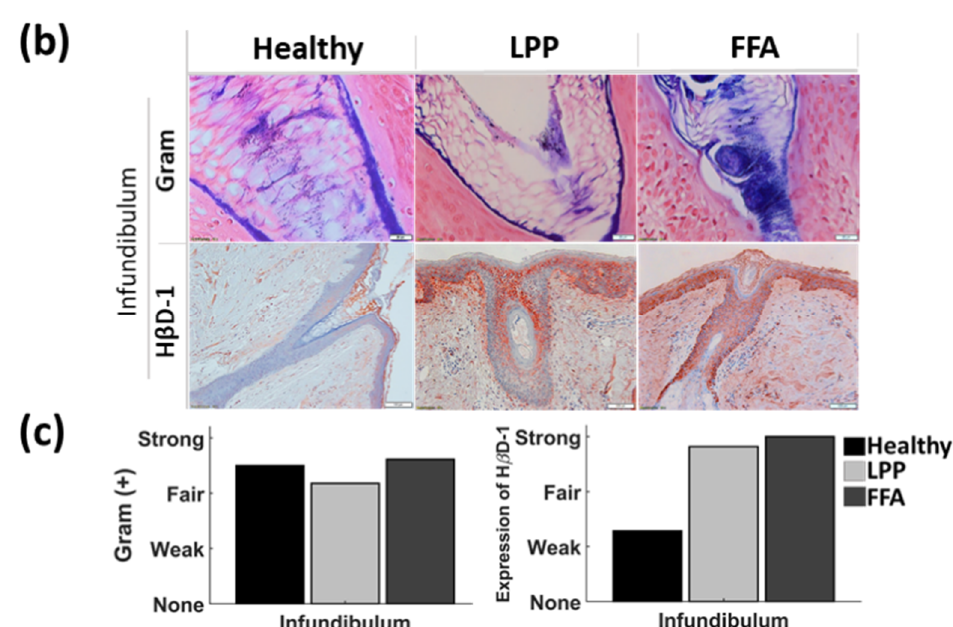
Figure 4. Bacterial profiling of the scalp surface of healthy subjects and alopecia patients. ( a ) Community composition of the scalp surface of healthy subjects and alopecia patients at the Genus level. Relative abundance (%) of the most abundant bacteria collected from scalp swabs, sampled from frontal (F) and occipital (O) scalps in healthy or lesional (L) and non-lesional (NL) scalp regions in patients. H ( n = 12), AAc ( n = 6), LPP ( n = 6), FFA ( n = 6). ( b ) Representative images at the level of HF infundibulum. Gram staining and HβD1 expression in paraffin-embedded sections of healthy scalp, and lesional scalp of cicatricial alopecia patients, assessed by immunohistochemistry. Magnification for Gram images × 400, bar scale = 20 µm, and for HβD1 images × 100, bar scale = 100 µm, respectively. ( c ) Semi-quantitative analysis of bacteria presence and the expression of HβD1 antimicrobial peptide at the level of infundibulum verifies the strong microbial colonization in HF openings and scalp surface. H ( n = 3), LPP ( n = 8), FFA ( n = 7). H, healthy; FFA, frontal fibrosing alopecia; LPP, lichen planopilaris; AAc, alopecia areata circumscripta; HF, hair follicle.